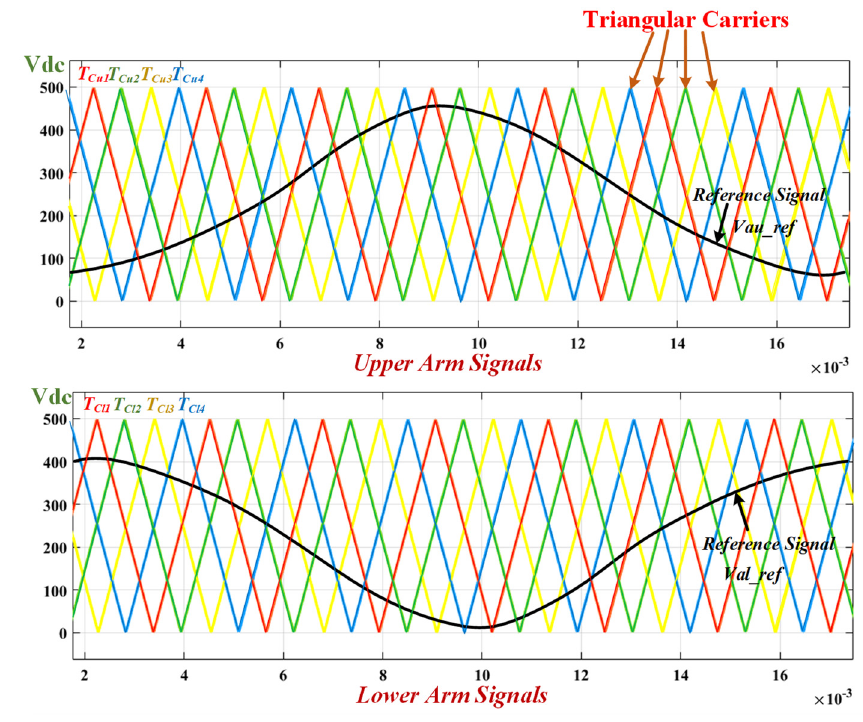
Figure 5. Simulation result for PSCPWM technique of MMC.